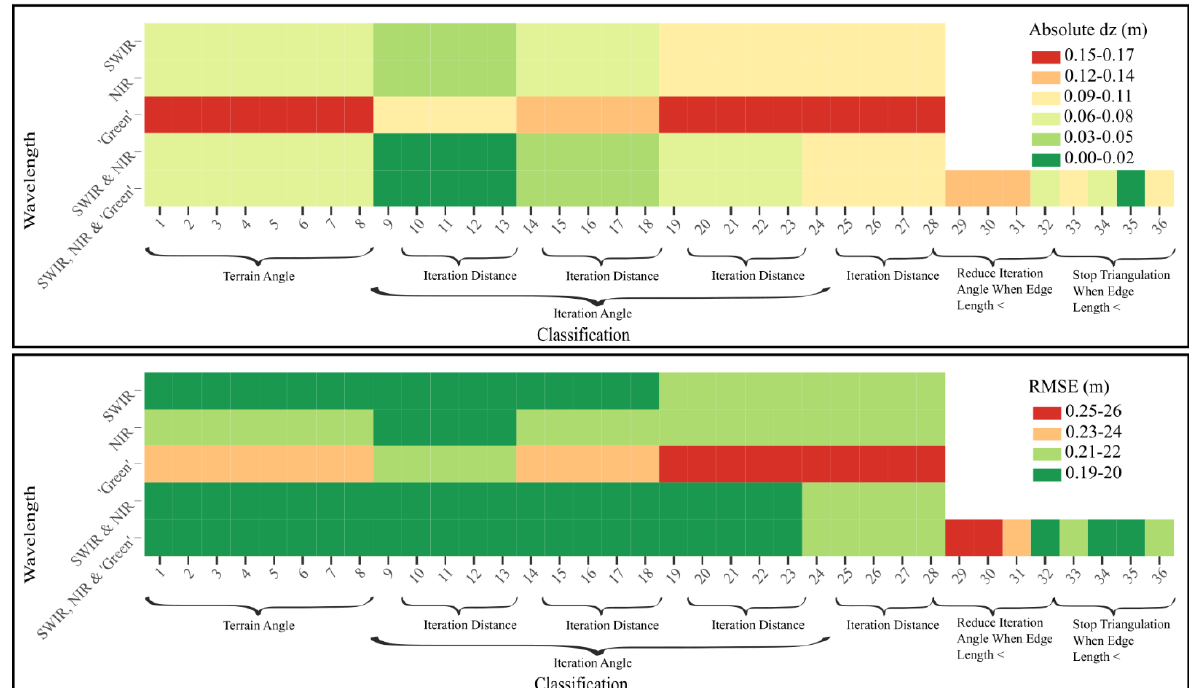
Figure 12. Ground classification results (| 𝑑𝑧̅̅̅ | and RMSE) in unburned peatlands. Classifications were conducted in TerraScan.